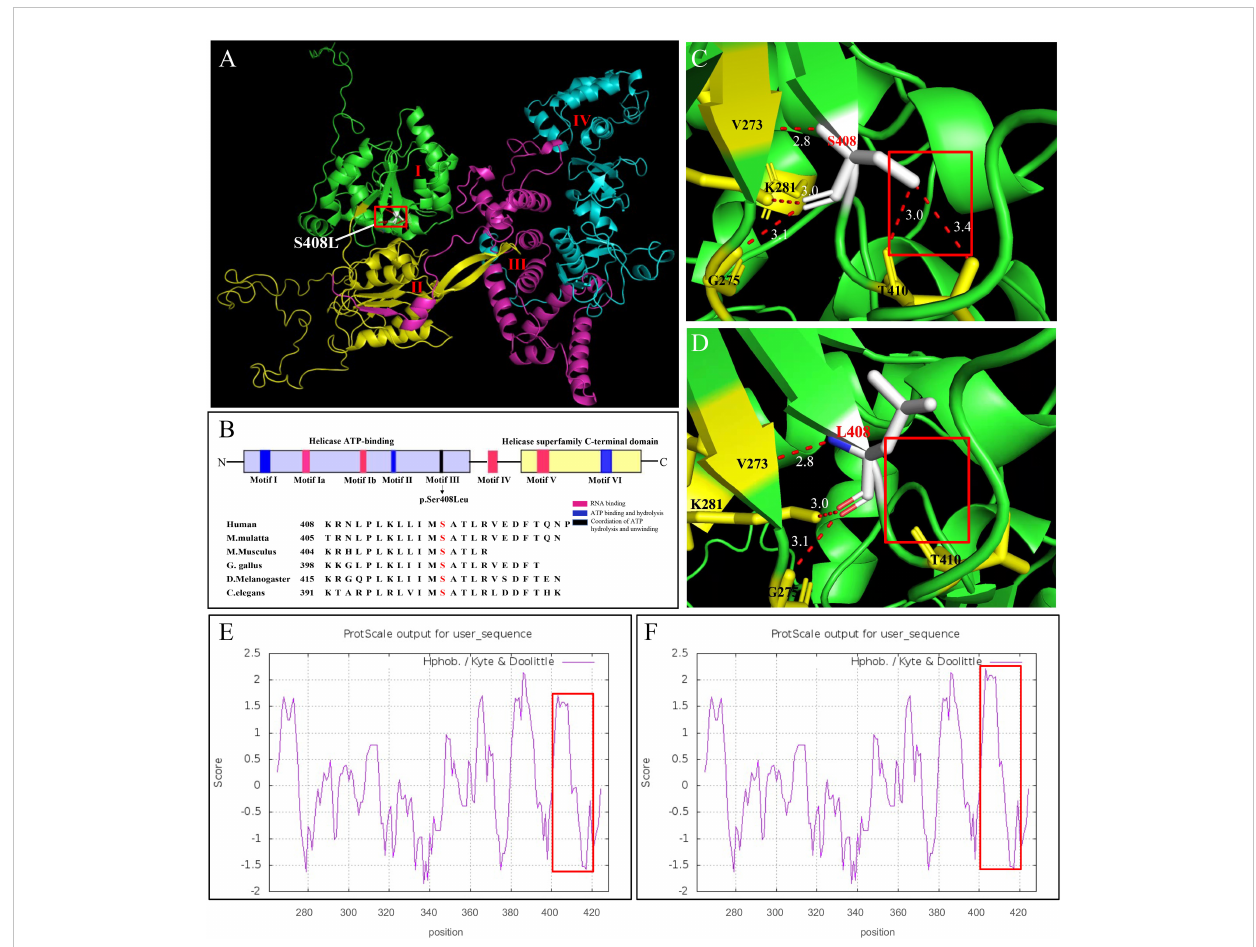
FIGURE 4 In silico modeling of DHX37. (A) Functional domains of a homology model of the DHX37 protein. The protein has four functional domains, which are color-coded and labeled. I: ATP-binding DEAH-box helicase (green), II: C-terminal helicase (yellow), III: helicase-associated 2 domain (purple), and oligonucleotide/oligosaccharide-binding-like domain (blue). The variant p.Ser408Leu is located in the helicase ATP-binding domain. (B) Schematic protein structure of the helicase core region, i.e., the helicase ATP-binding domain and the helicase superfamily C-terminal domain. Colors represent the main helicase functions. Sequence alignment shows the conservation of the amino acid residue S408 across different species. The variant p.S408L falls within the Motif III, which is implicated in the coordination of ATP hydrolysis and unwinding. A zoomed-in view of protein model with residue S408 (C) and L408 (D) . S408 and T410 and V273 and G275 were linked by hydrogen bonds in the wild type. After the mutation, the hydrogen bonds between S408 and T410 disappeared. N-, N terminus; -C, C terminus. Kyte and Doolittle hydropathy plot of the DHX37 protein (E) before and (F) after p.S408L mutation. A score >0 means hydrophobic and <0 means hydrophilic. Higher positive values indicate greater hydrophobicity. The mutation caused increased hydrophobicity in the region between codons 400 and 420, as outlined by red